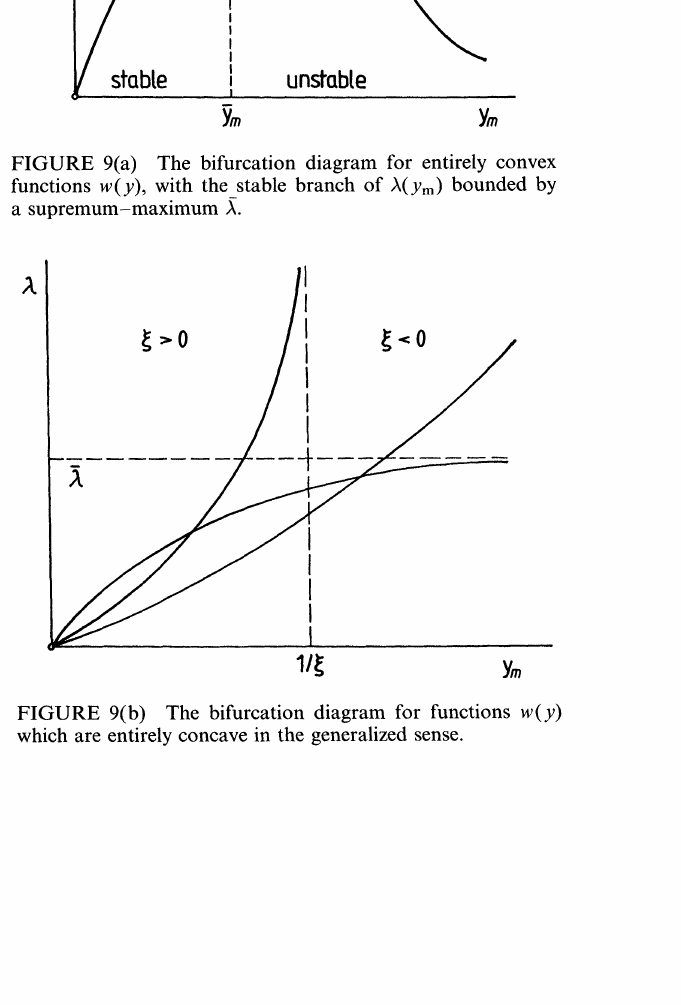
inflection Q with a horizontal tangent (cf. Fig. 7)